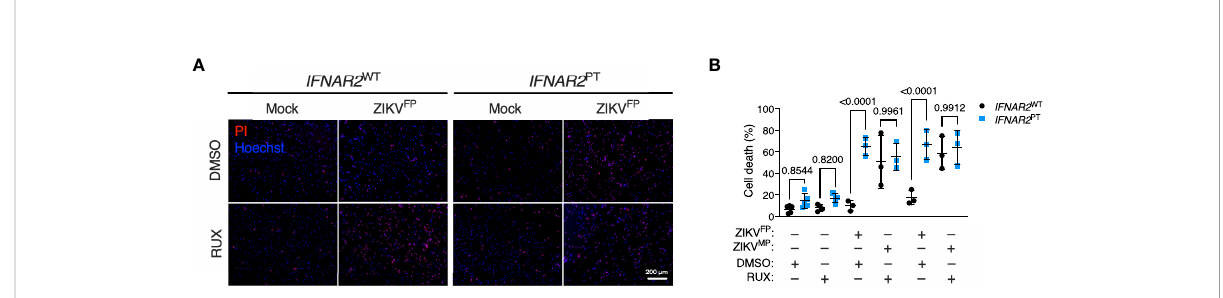
FIGURE 6 JAK inhibition recapitulates ZIKV cytopathicity in wild-type iPS-macrophages. (A) Immuno fl uorescence analysis of cell viability showing representative images of cell death at 72 h.p.i. in IFNAR2 WT (WT1) and IFNAR2 PT (clone 11) iPS-M f treated with RUX (10 uM) or DMSO control (ZIKV FP MOI = 1.0, representative images of n = 4 independent experiments). Scale bar = 200 m m. PI = propidium iodide. (B) CellPro fi ler quanti fi cation of cell viability assay in IFNAR2 PT (clone 11) and IFNAR2 WT (WT1 and WT2) iPS-M f treated with RUX (10 uM) or DMSO control (72 h.p.i. ZIKV FP MOI = 1.0, n = 4 independent experiments and ZIKV MP MOI = 1.0, n = 3 independent experiments). Mean ± SD, ANOVA with Sidak ’ s test for multiple comparisons.